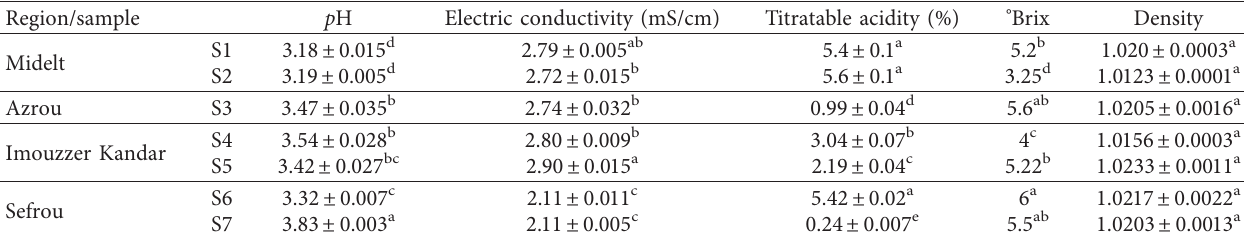
Table 2: Vinegars physicochemical characterization.